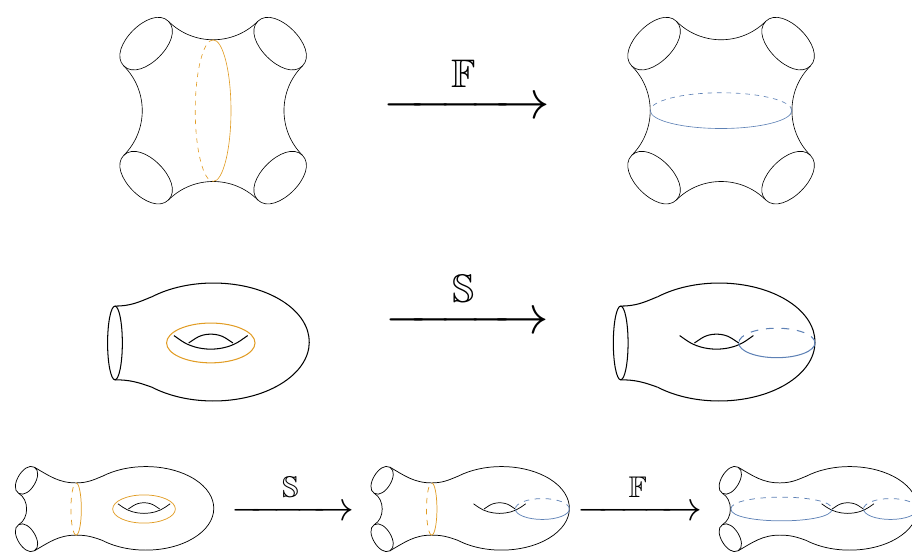
Figure 5 . The elementary crossing moves relate di(cid:11)erent pair-of-pants decompositions of the four- punctured sphere and the once-punctured torus, or more generally anywhere that these appear as pieces of any decomposition of a surface. The associated crossing kernels relate Virasoro conformal blocks in the corresponding channels. The fusion kernel (top) relates sphere four-point Virasoro blocks in the S- and T-channels, and the modular kernel (middle) relates torus one-point blocks in modular S -transformed frames. In the (cid:12)nal line, we show an example relating two channels in the torus two-point function G 1 ; 2 by composing these